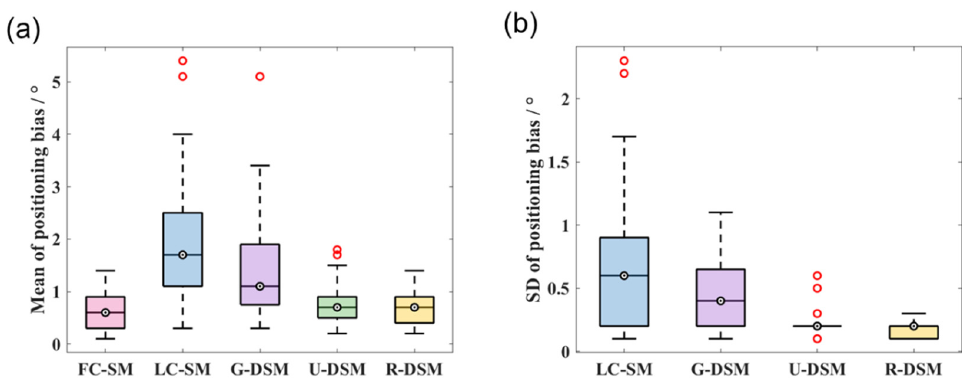
Figure 15. Box plots of ( a ) mean values and ( b ) SD values of positioning bias at 36 different source positions for 137 Cs source in intra-device evaluation.